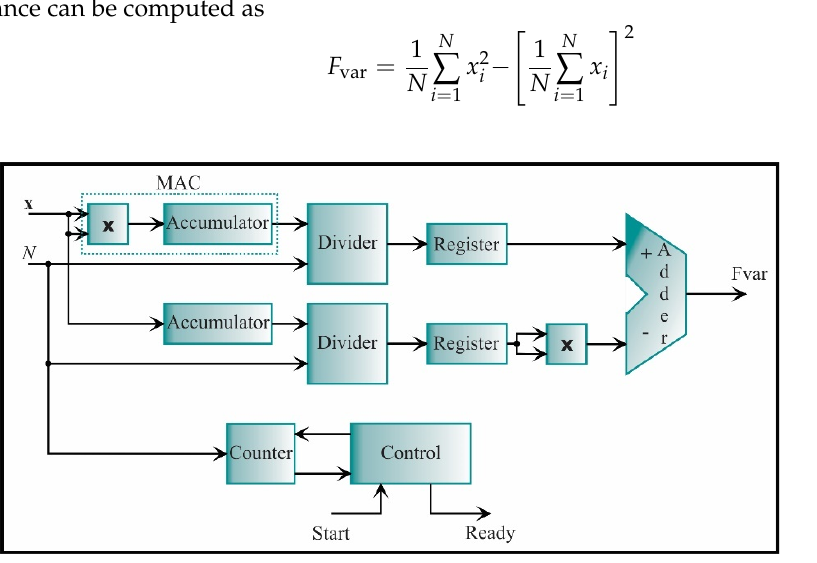
Figure 14. The architecture of the processing core for computing the variance.